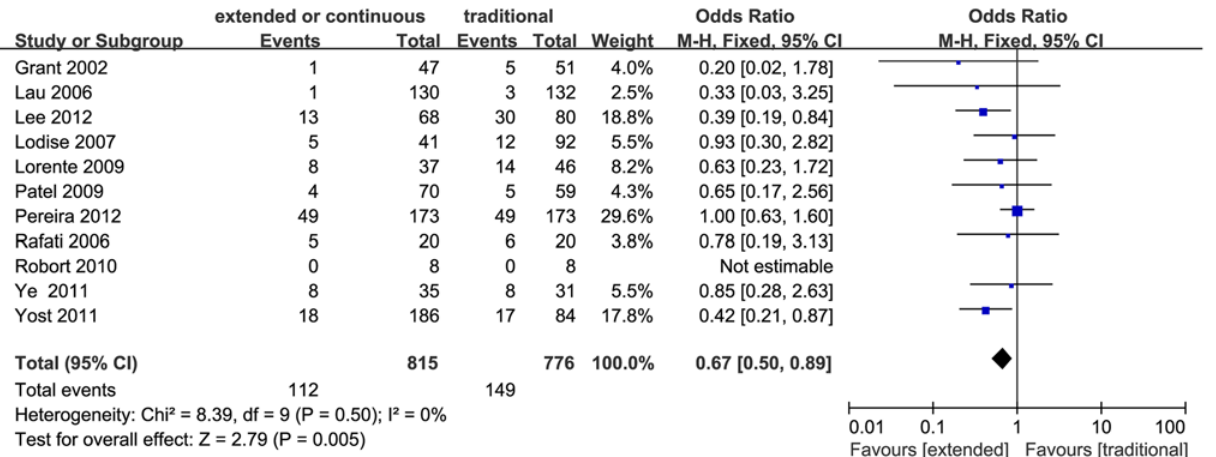
Figure 3. Forest plot depicting the odds ratios of mortality of patients receiving extended or continuous versus conventional intermittent infusion of piperacillin/tazobactam.